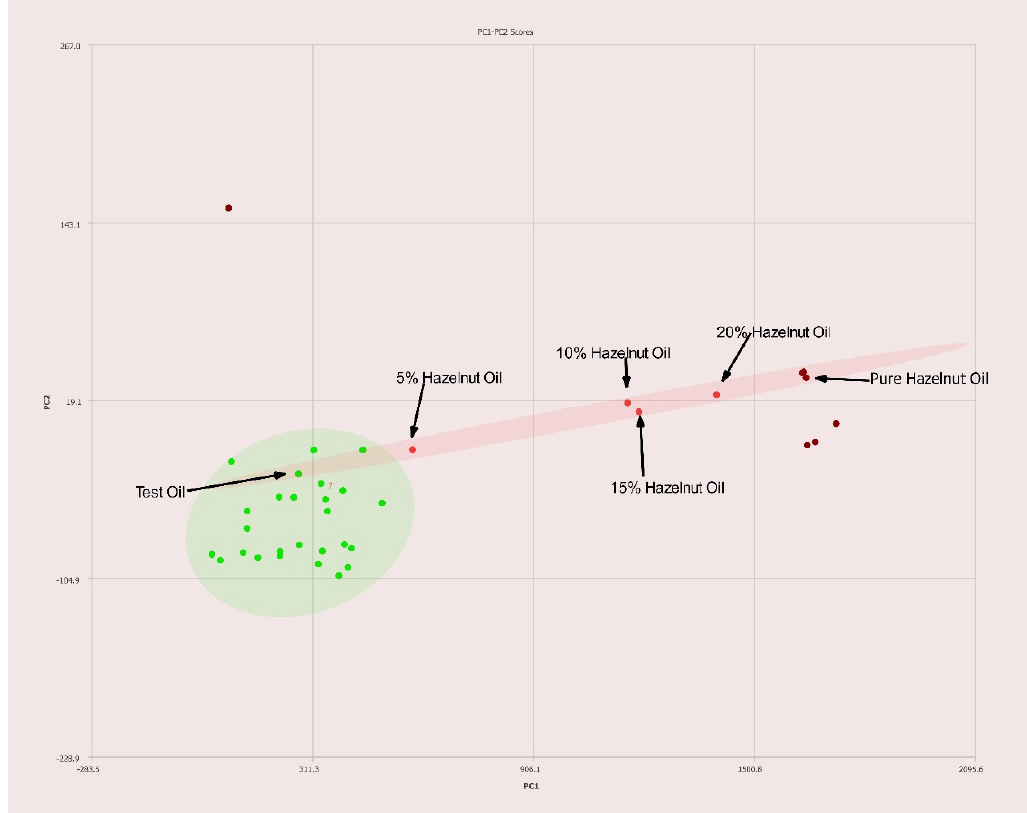
Figure 7. PC1–PC2 plot of 400 MHz 1 H NMR spectra of olive oil adulterated with hazelnut oil with percentages of adulteration noted. Ellipses represent the 95% confidence interval.